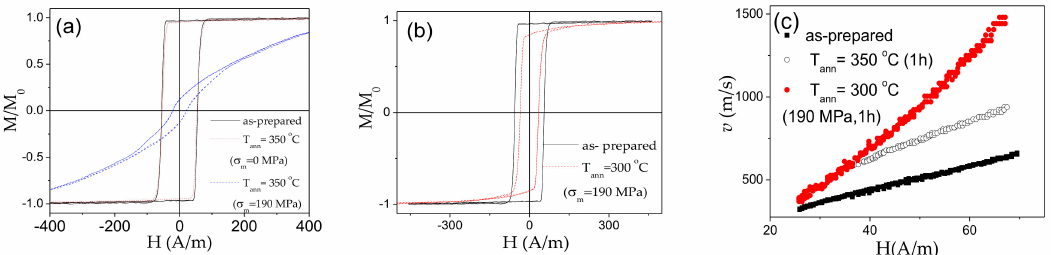
Figure 9. Hysteresis loops of as-prepared, annealed and stress- annealed at T ann = 350 ◦ C Fe 75 B 9 Si 12 C 4 microwires ( a ), hysteresis loops of as-prepared and stress-annealed at 300 ◦ C Fe 75 B 9 Si 12 C 4 microwires ( b ) and v(H) dependencies of as-prepared, annealed at T ann = 350 ◦ C and stress-annealed at T ann = 300 ◦ C Fe 75 B 9 Si 12 C 4 microwires ( c ).